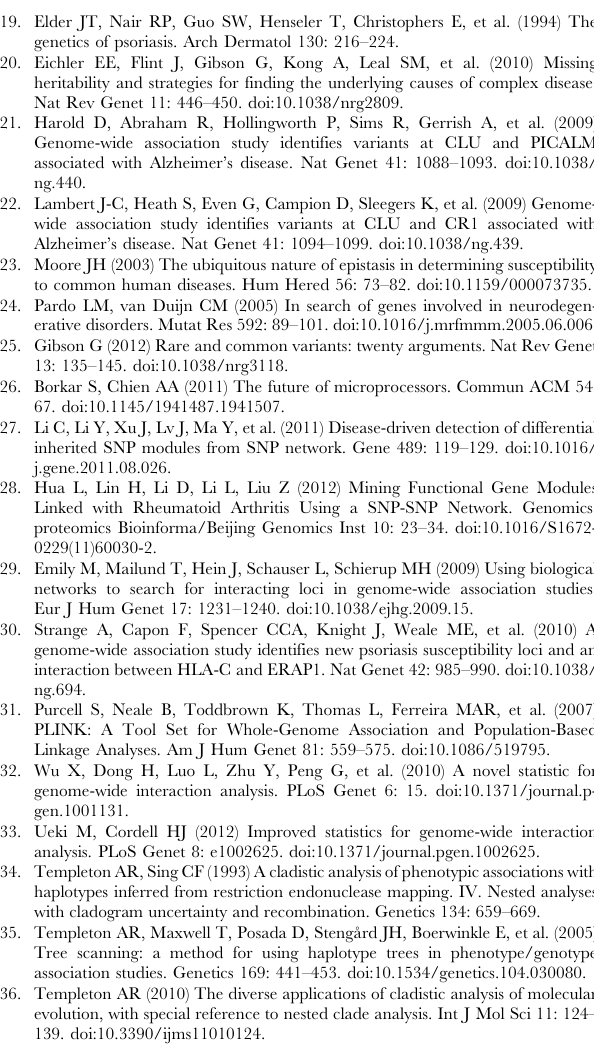
Table S1 List of SNP alleles in 30-node bloc from 500,000 edge